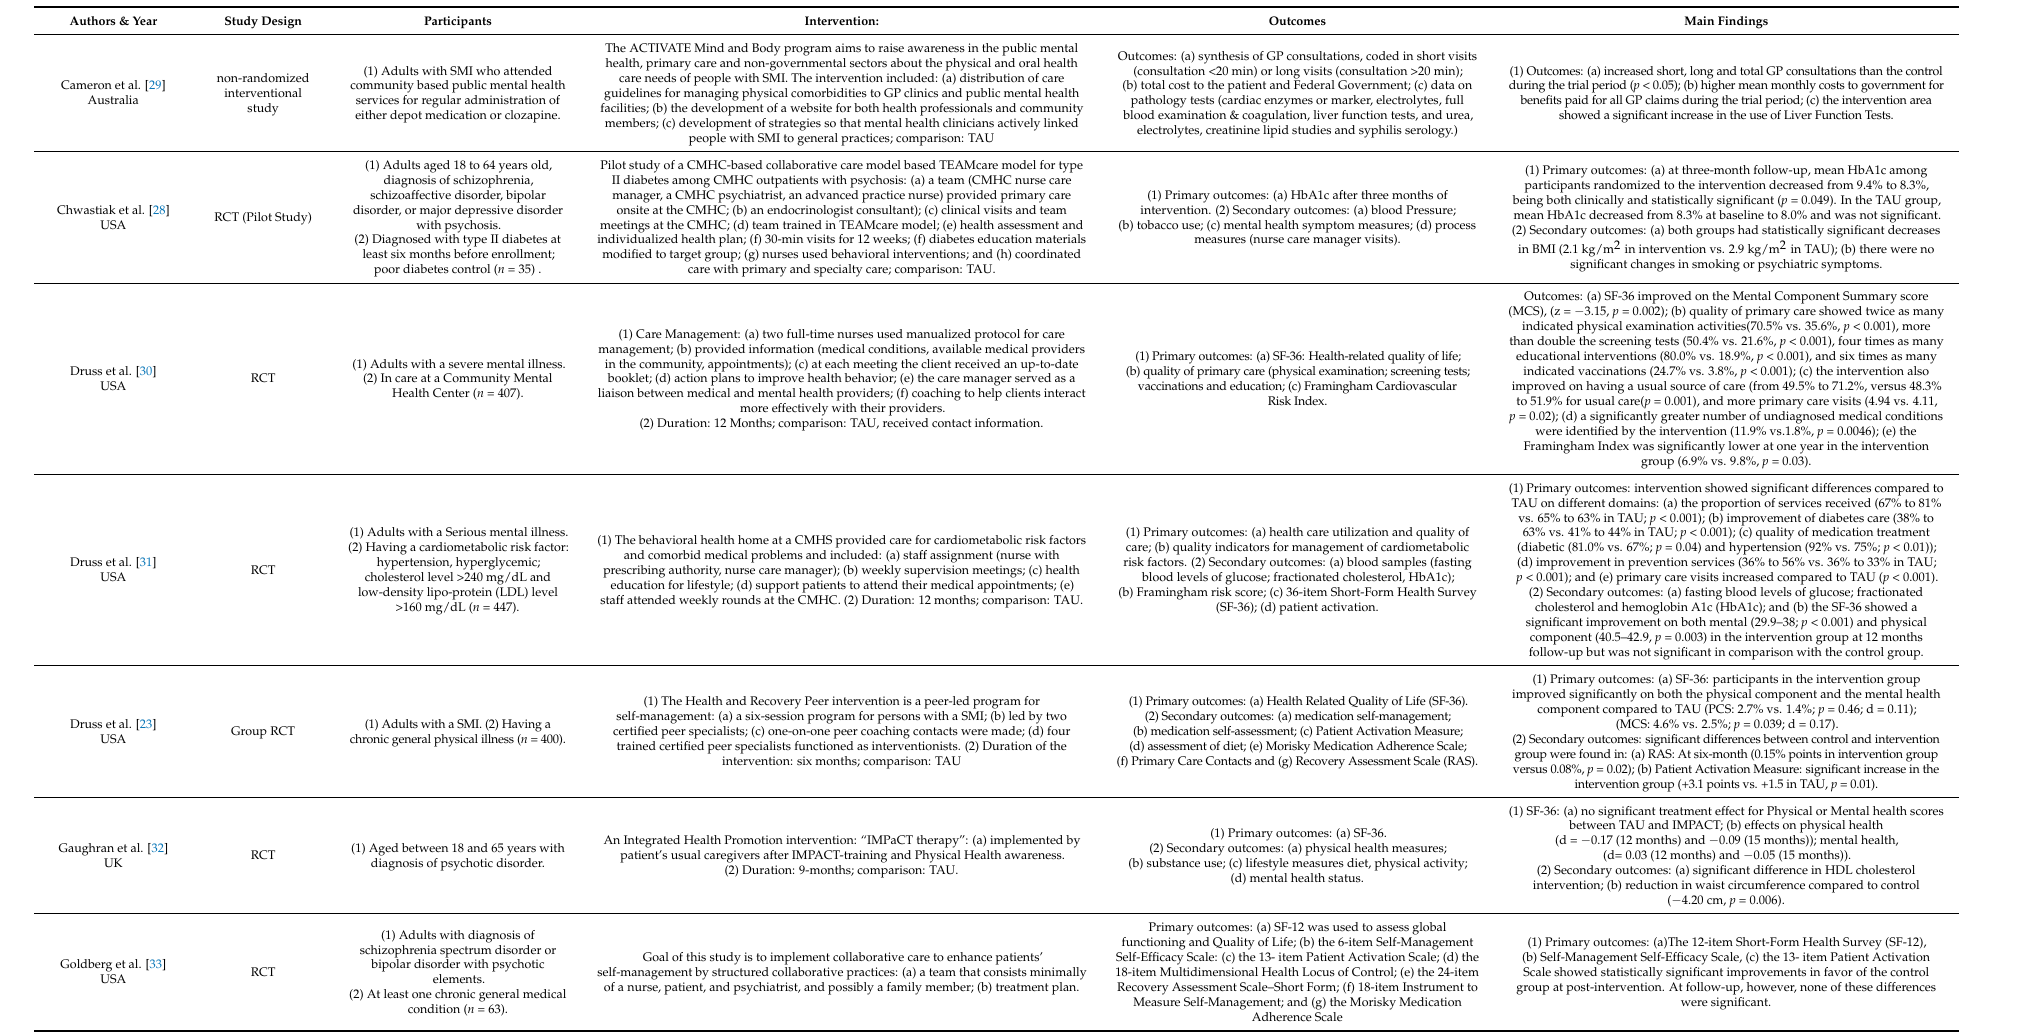
Table 2. Overview of Included